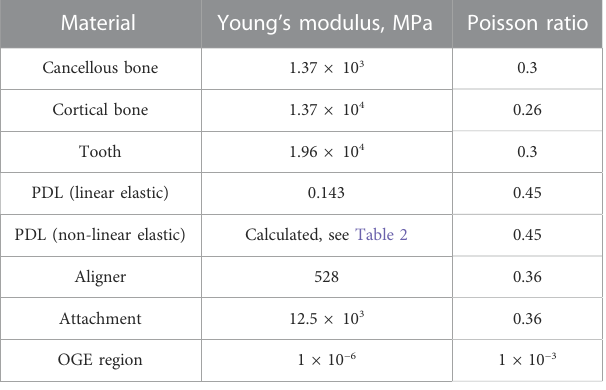
TABLE 1 Properties of the materials considered in this study.